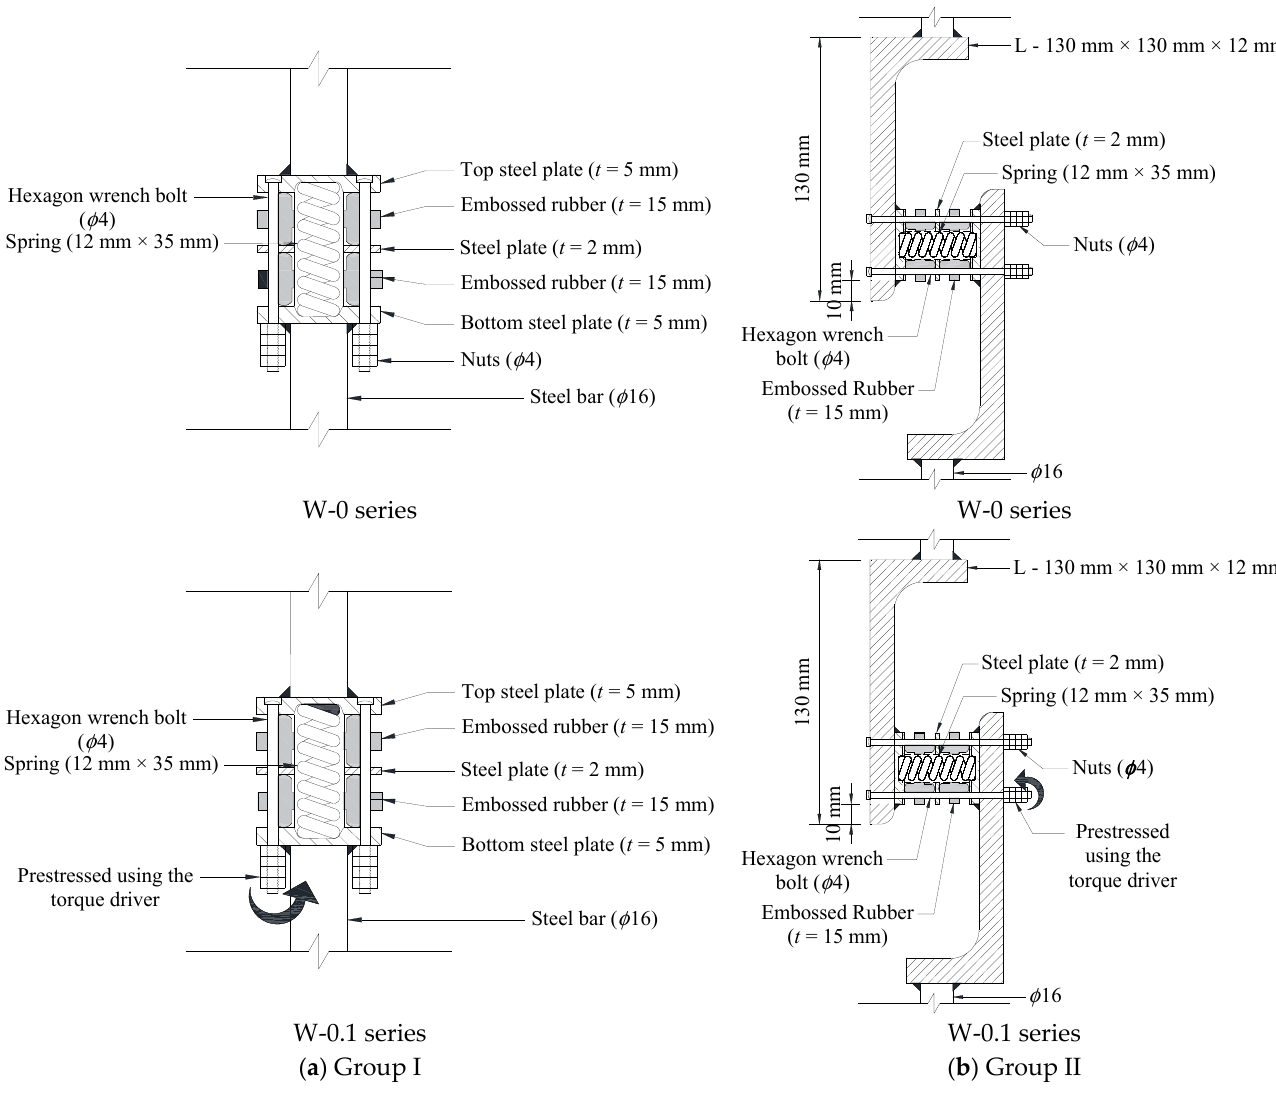
Figure 2. Details of the SDI specimens: ( a ) Group I; ( b ) Group II. Table 1. Details of SDI specimens. The total thickness of the embossed rubber was 15 mm and the diameter and height of the protrusions were 5 mm each. There were six protrusions at the top and the bottom. The diameter and thickness of the steel plate inserted between the rubbers were 35 mm and 2 mm, respectively. To install the spring and bolts, the embossed rubber and steel plate had holes with diameters of 14 mm and 4 mm at the center and edge, respectively. The top and bottom plates were threaded so that the spring could be fixed therein and had three holes with a diameter of 4 mm diameter in line with the same position as the embossed rubber and steel plate at the edge. The inner and outer diameters of the spring were 6 and 12 mm, respectively, and the diameter of the spring wire was 1 mm. In addition, the height of the spring was 35 mm. Hexagonal wrench bolts with a diameter of 4 mm were used to easily tighten the bolts using the torque